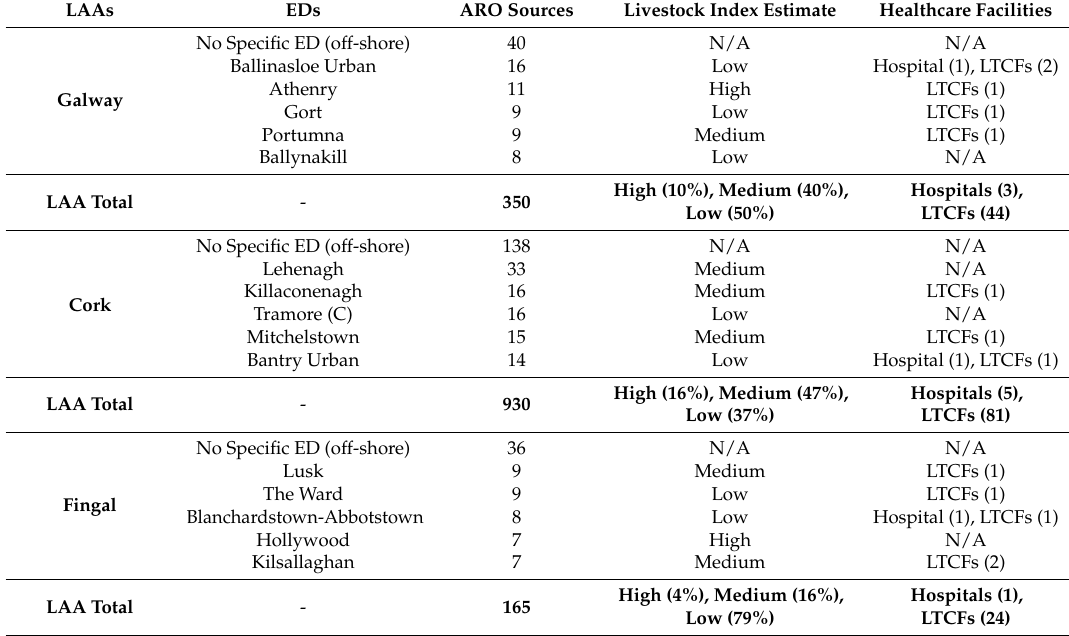
Table 2. Summary statistics for potential sources of antimicrobial resistant organisms (AROs), livestock index estimates, and healthcare facilities identified in the mapping